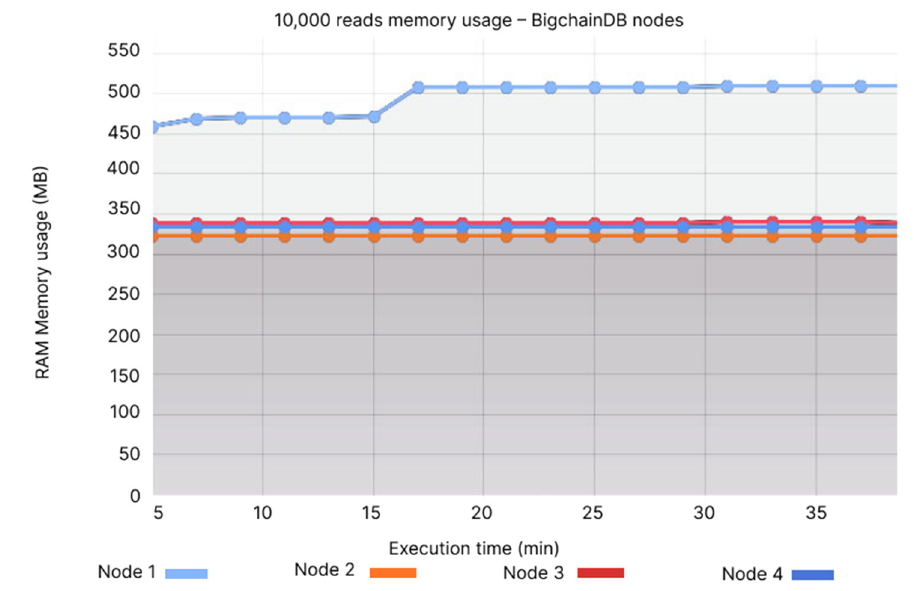
Figure 28. 10,000 reads memory usage—BigchainDB nodes.